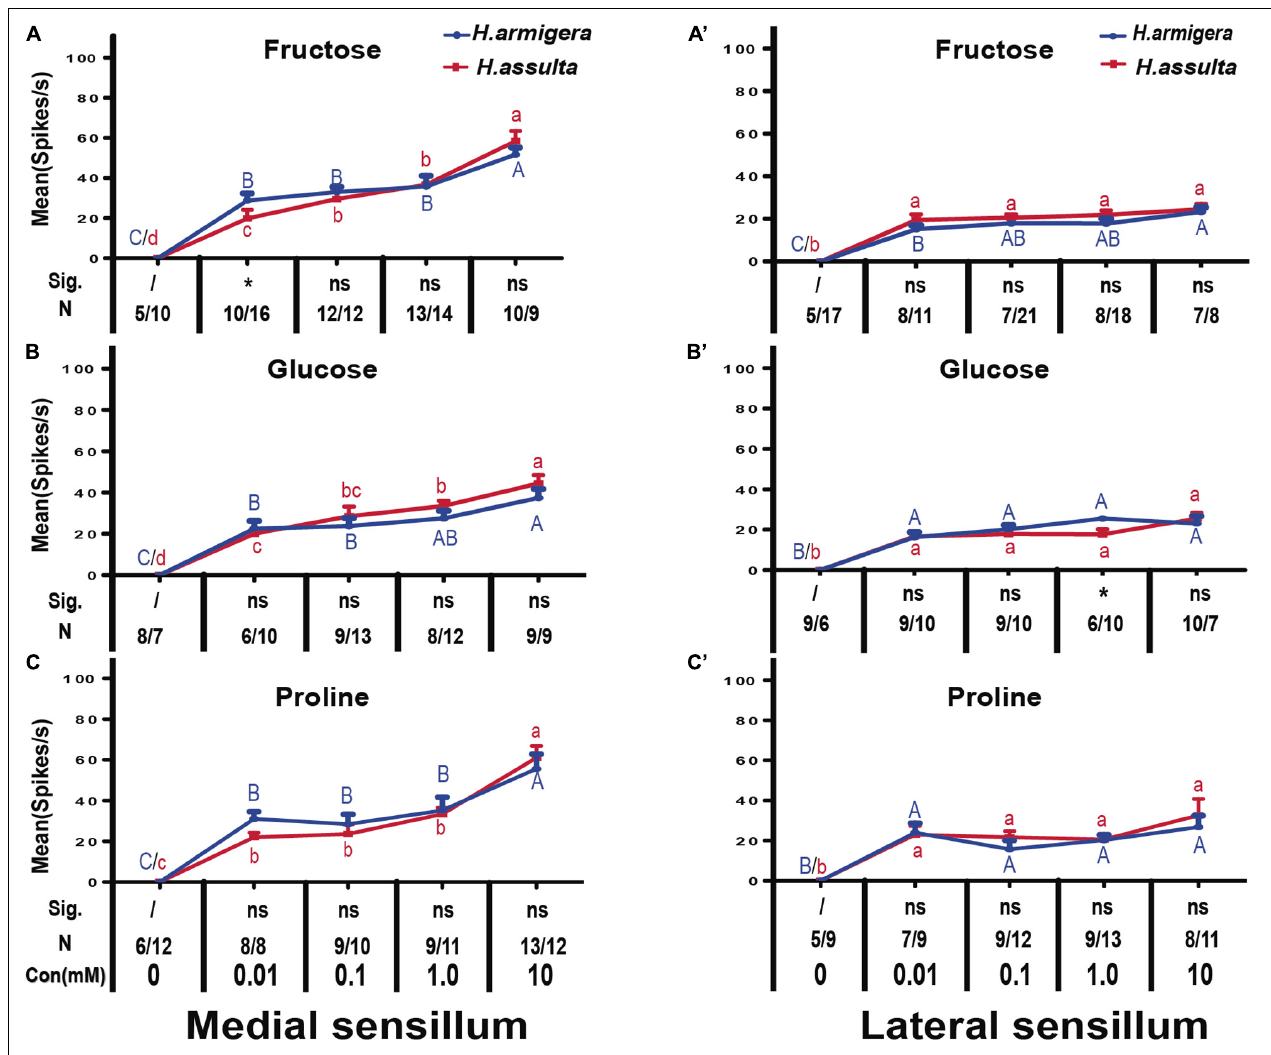
FIGURE 2 | Comparisons of gustatory responses of “M1” GNRs in styloconic sensilla of Helicoverpa caterpillars to plant primary metabolites. Curves show the mean responding frequency ± SE of “M1” GNRs in the medial sensillum (A–C) and in the lateral sensillum (A’–C’) of Helicoverpa caterpillars to plant primary metabolites from 0.01 to 10 mM. Different capital letters and lowercase letters represent the mean responding frequencies of “M1” GNRs were significantly different in response to one primary metabolite at different concentrations in caterpillars of H. armigera and H. assulta , respectively ( post-hoc SNK test of ANOVA: P < 0.05). Independent t -test was used to compare the difference of the mean responding frequency of “M1” GNRs to the same compound at the same concentration between the two Helicoverpa species. “Sig.” represents the levels of difference. “ns”: no significant different ( P > 0.05); “*” represents the difference was significant at the 0.05 level. “N” represents the number of tested caterpillars of H. armigera / H. assulta .